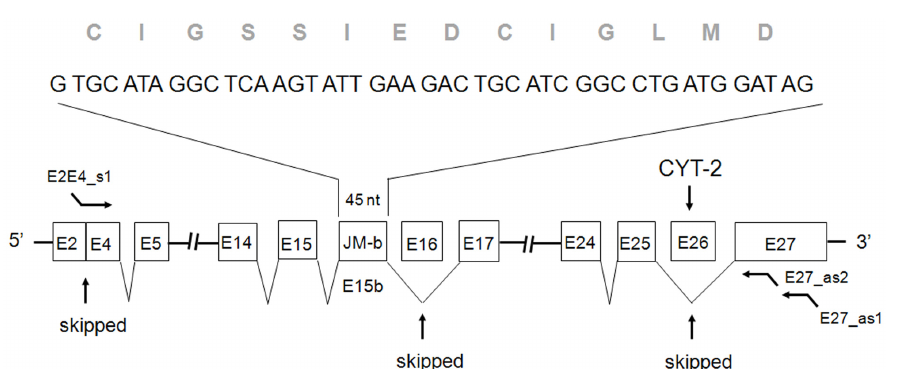
Figure 2. The ErbB4 del.3/CYT2 variant exists as a JM-b isoform in the human fetal brain. Open boxes represent exons. The horizontal lines with the first ‘‘//’’ sign represent exons E6 to E13. Horizontal lines with the second ‘‘//’’ sign represent exons from E18 to E23. The PCR primers are indicated as forward or reverse bent arrows, respectively. Names of the primers are shown. The three spliced exons (exons 3, 16, and 26) are indicated. The 14 aa sequence encoded by the 45-nt, specific for the JM-b isoform, is shown.